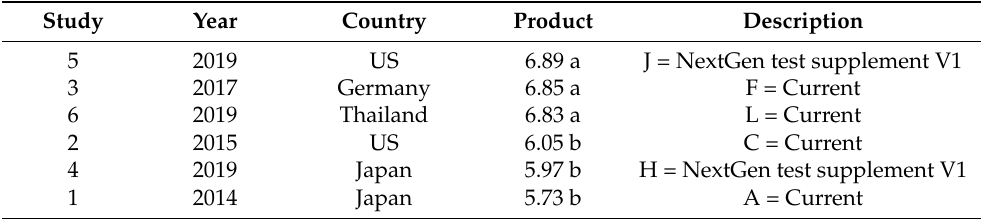
Table 2. Overall liking mean ratings (average of Monday and Friday)—current in-market product effects by study across